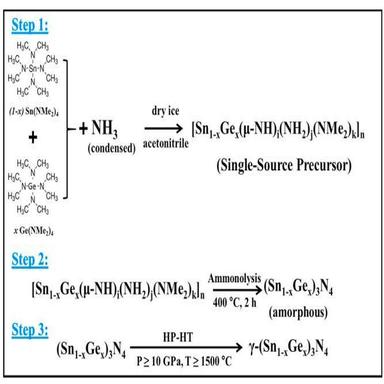
Preparation of single-source precursors as starting material for the synthesis of high-pressure γ-M3N4 solid solutions or ternary nitrides with M = Ge and Sn. Other nitride-based compounds or solid solutions with group 4 and 14 elements can be synthesized by mixing 2 or more different metal dimethylamino compounds in Step 1 (R. Riedel et al., unpublished work).